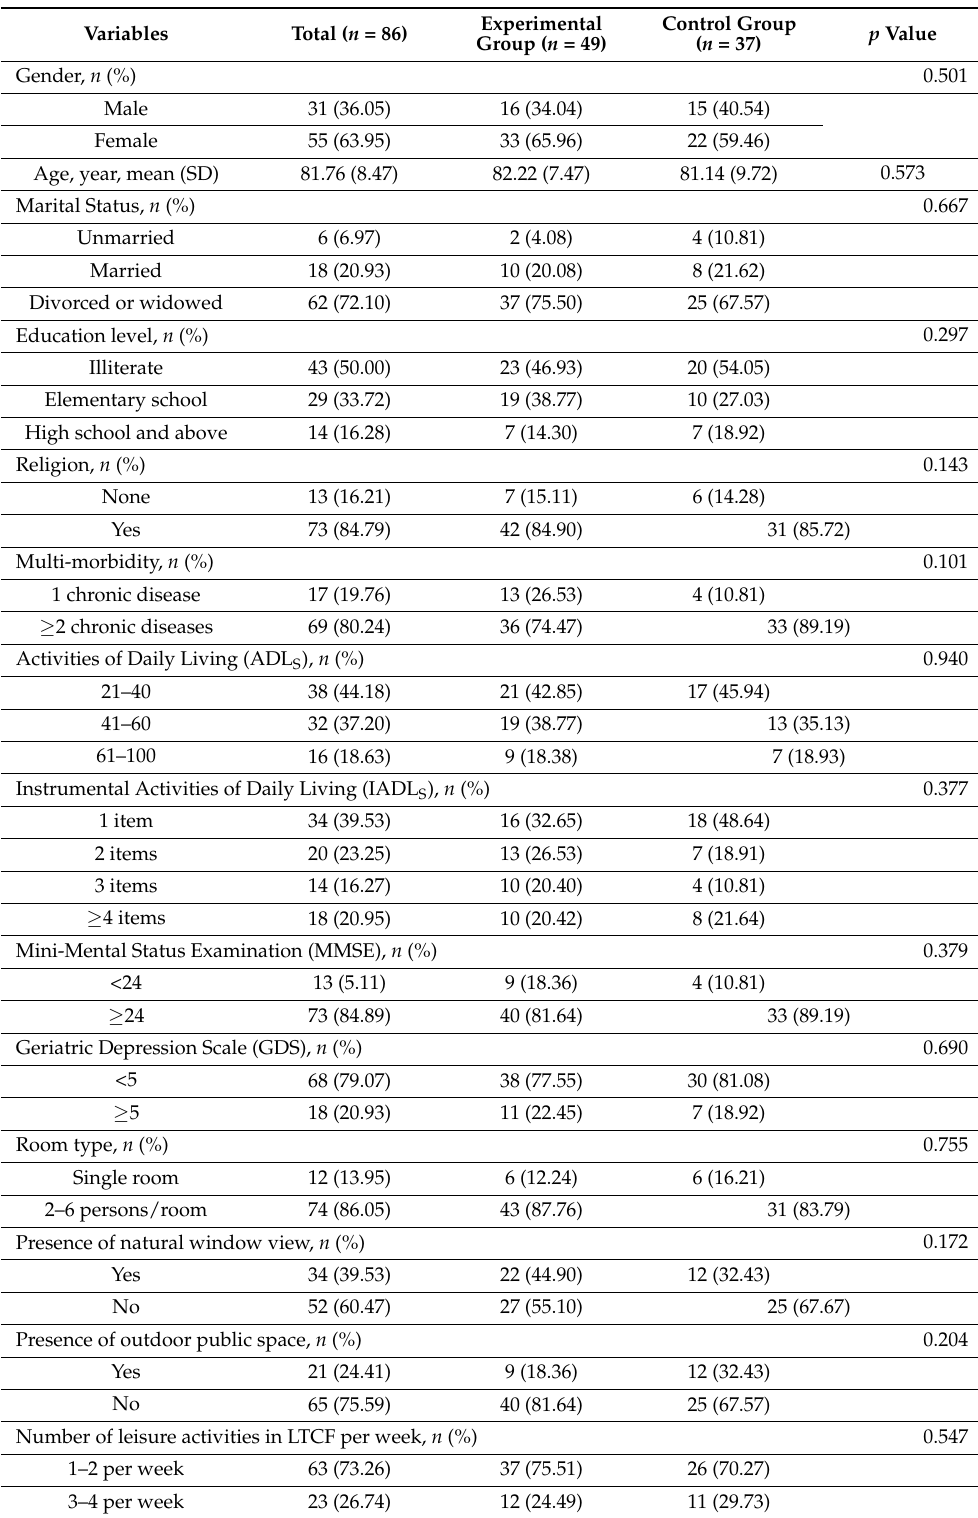
Table 1. Baseline characteristics of participants ( n =